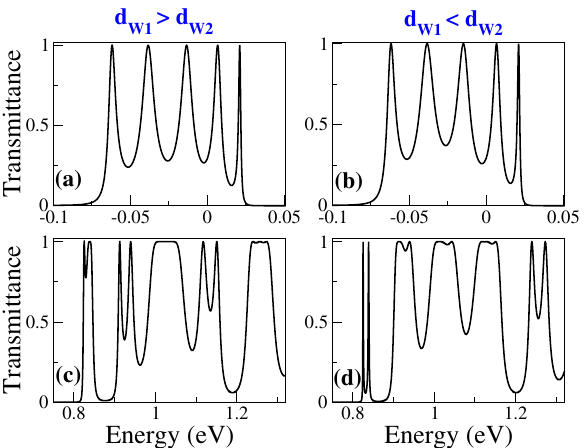
Figure 5. Transmission bands of BPGGSLs in which is not evident the contribution of transparent states. The angle of incidence in all cases is θ = 60 ◦ . The superlattice parameters of ( a ) and ( c ) are the same as in Fig. 2 and the ones of ( b ) and ( d ) are the same as in Fig. 3.